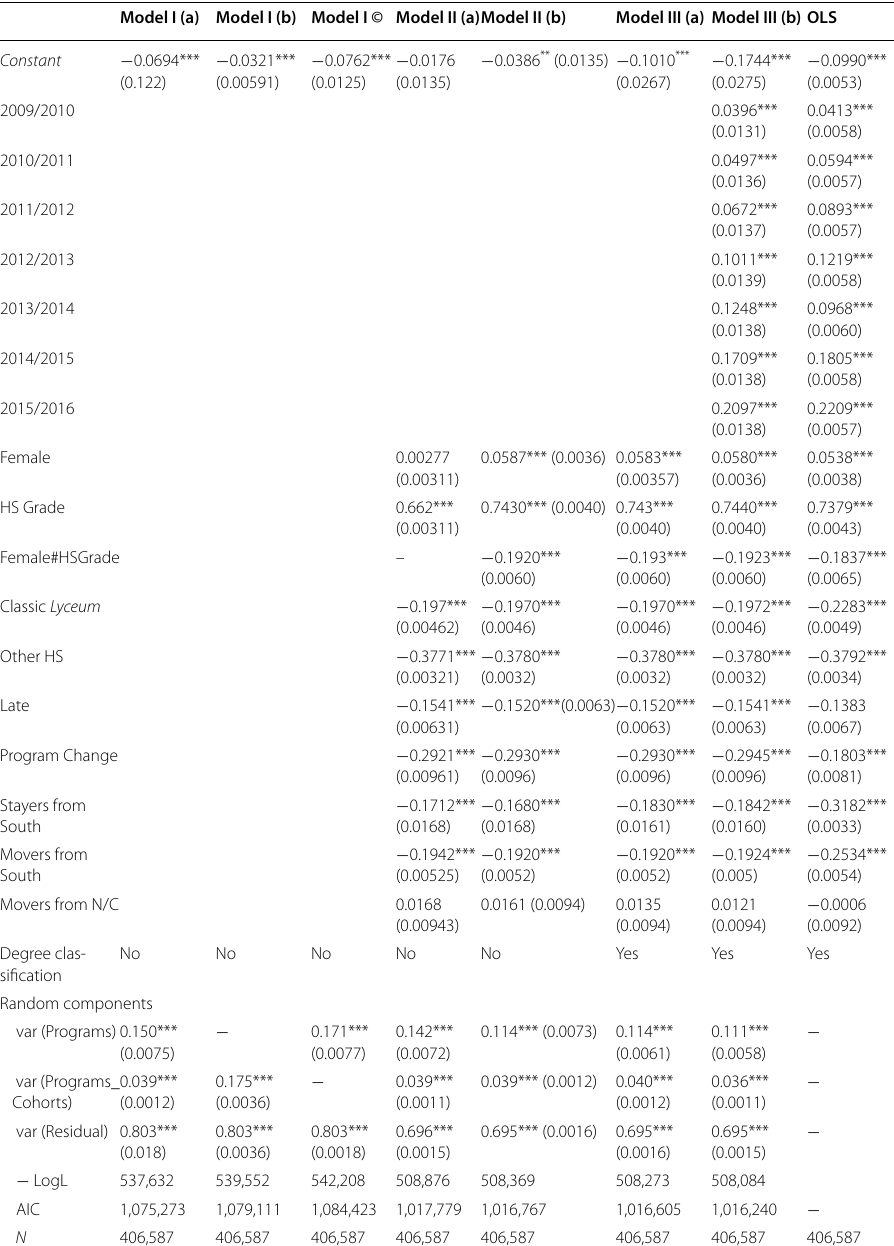
Table 3 Variance component model and OLS